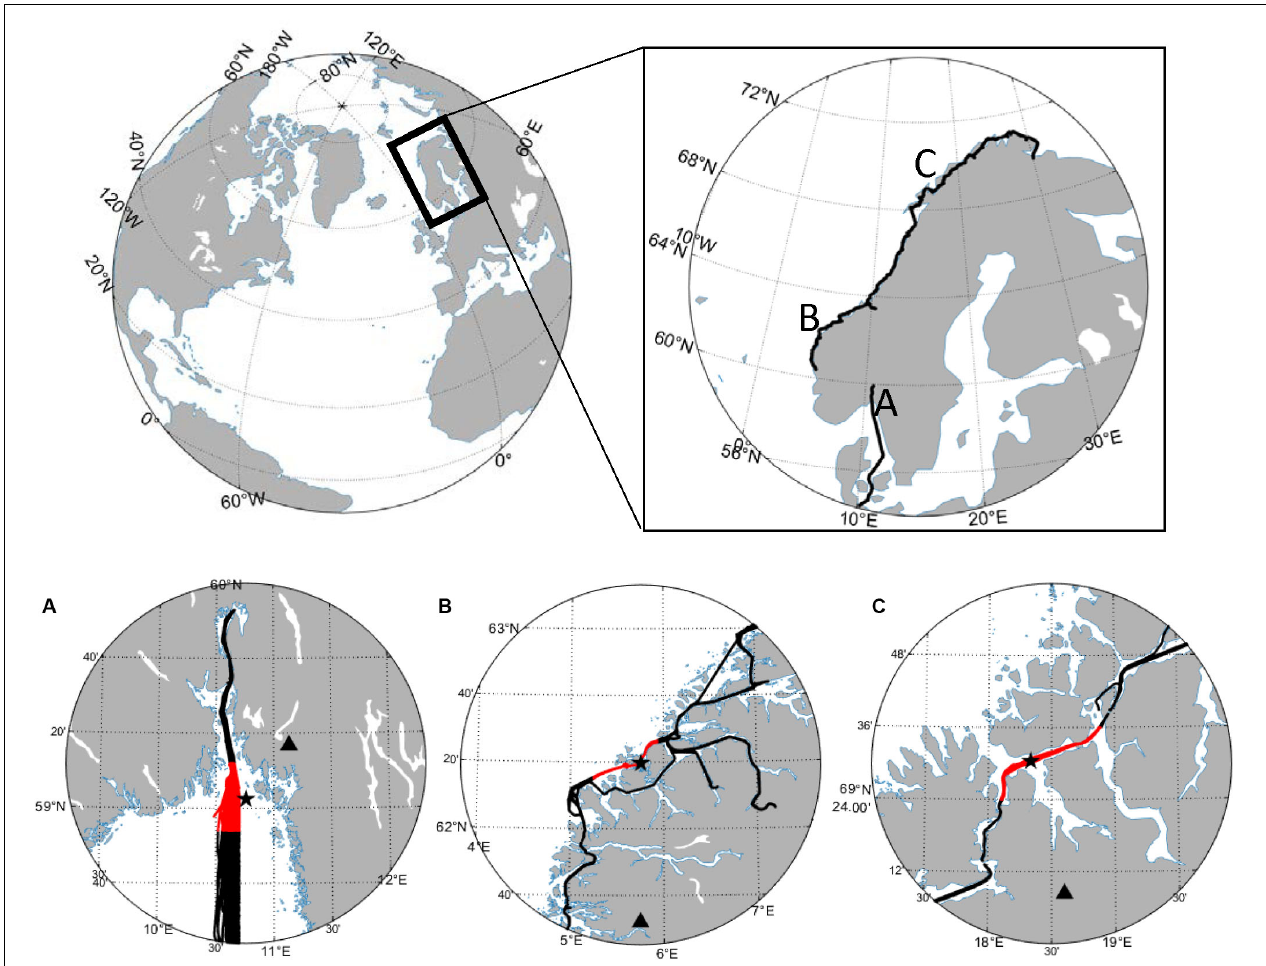
FIGURE 1 | Overview of three study regions in (A) Outer Oslofjord/southern Norway, (B) Runde/western Norway, and (C) Malangen/northern Norway. Top panel shows location along Norwegian coastline with full FerryBox transects. Bottom panel shows zoomed-in view of the study sites, FerryBox transects (black line), part of FerryBox lines examined along with water column data (red line), the location of water column stations (star), and river monitoring gauging stations (triangle). The river monitoring gauging stations are present at river Glomma, Nausta, and Målselv for study regions (A–C) , respectively.